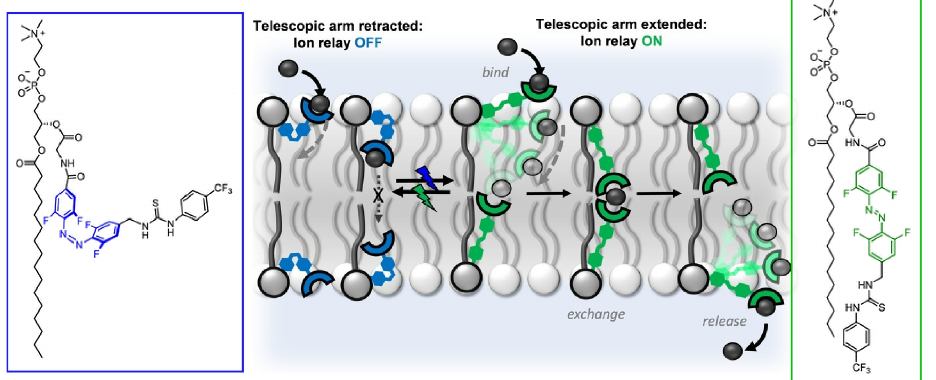
Figure 9. Artificial ion transporter on the opposite side of a lipid bilayer can serve as a molecular machine-like ion transport relay using a photo-responsive stretchable arm. Reproduced under terms of the CC-BY license [136].